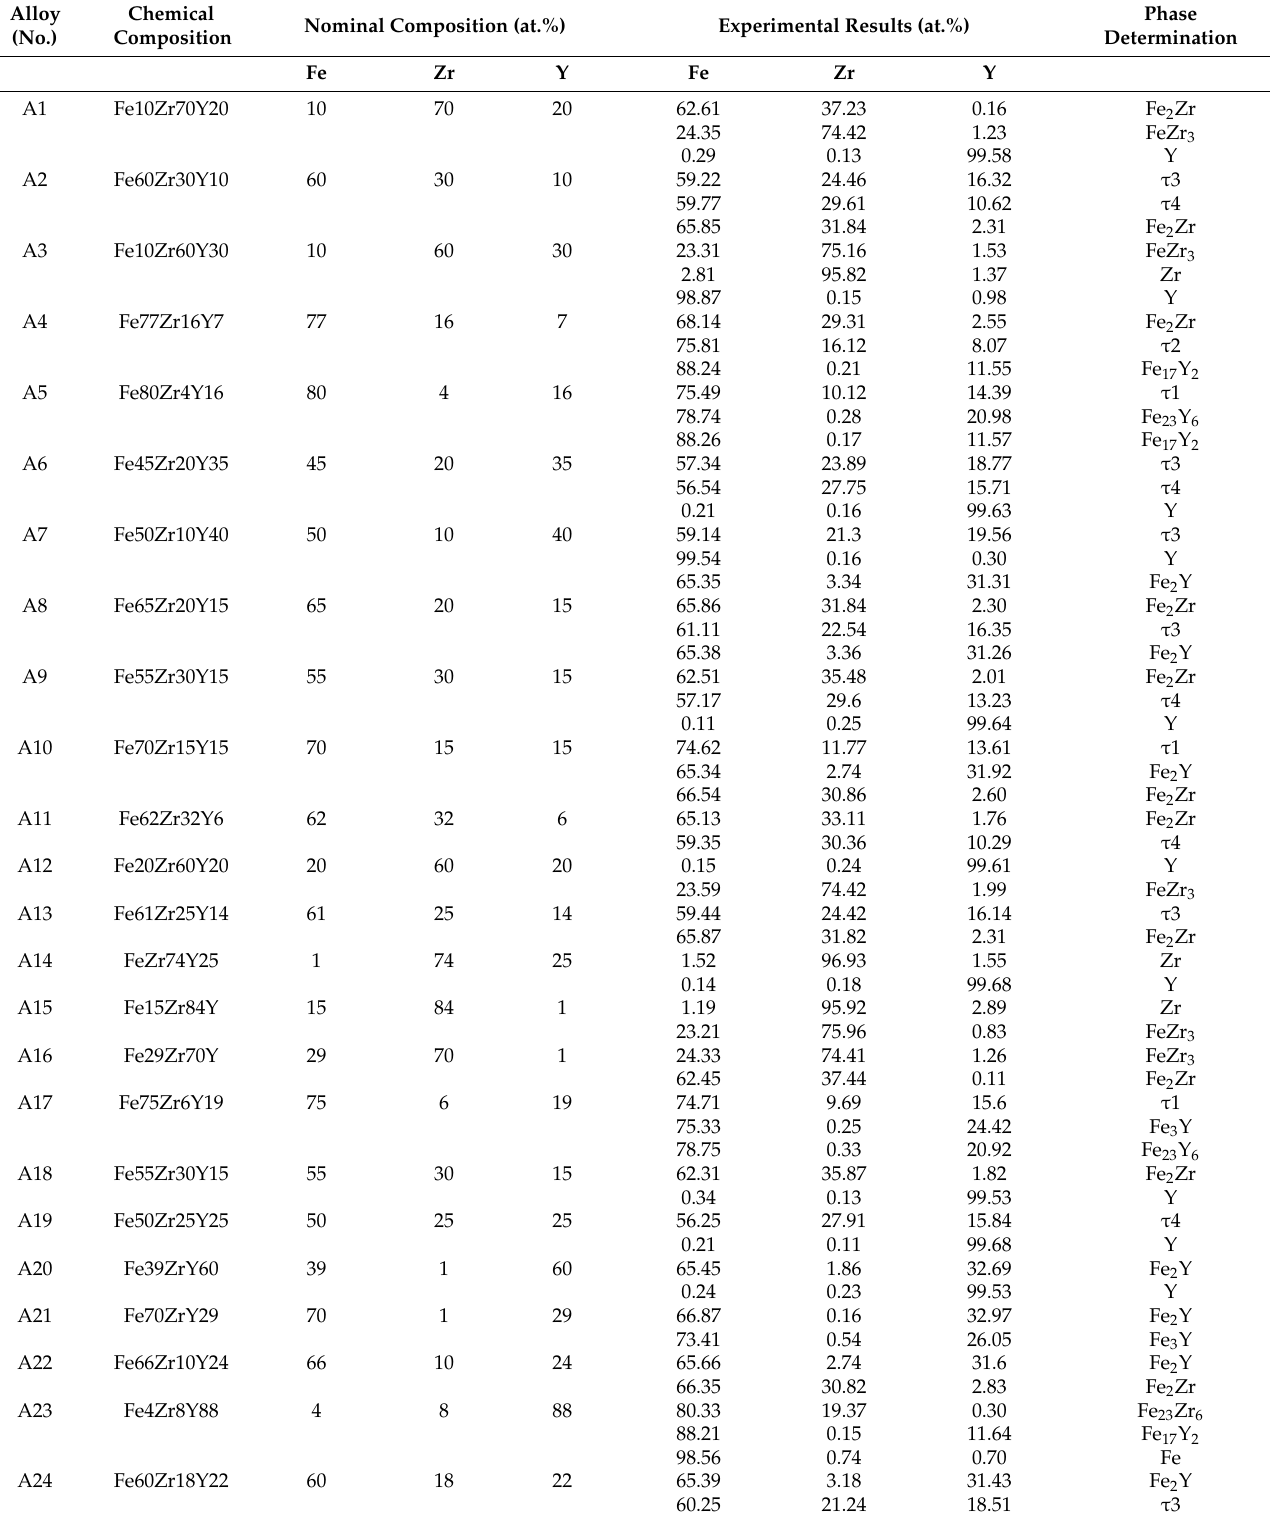
Table 2. Constituent phases and compositions in the annealed Fe-Zr-Y alloys at 973 K for 90 days. Alloy (No.)